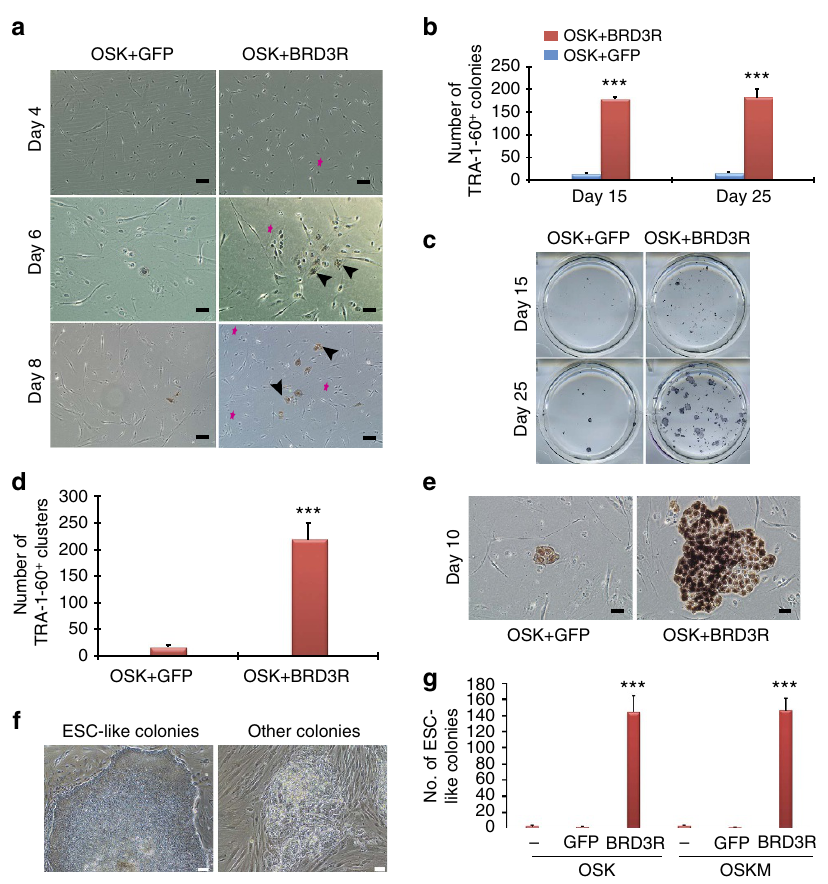
Figure 2 | BRD3R speeds up reprogramming kinetics and enhances the quality of reprogramming. ( a ) Representative images showing early appearance of TRA-1-60 þ clusters in BRD3R reprogramming. Arrowhead, TRA-1-60 þ clusters; magenta star, compact rounded cells resembling mitotic cells and ESC morphology. ( b ) Significant higher TRA-1-60 þ colonies in middle stage of reprogramming (day 15) ( n ¼ 3; mean ± s.d.; *** P o 0.001; t -test). ( c ) Representative images of reprogramming dishes stained for TRA-1-60 on day 15 and day 25 from experiments in b . Note the larger colonies in BRD3R reprogramming. ( d ) Significantly more TRA-1-60 þ clusters are found at early stage of reprogramming (day 10) ( n ¼ 3; mean ± s.d.; *** P o 0.001; t -test). ( e ) Representative images of the TRA-1-60 þ clusters from experiments in d to show the larger size of clusters in BRD3R dishes. ( f ) Representative images of ESC-like colonies (left) and low-quality colonies (right) on which the quantification in g was based. ESC-like colony has clear border with smooth colony surface and contains homogeneous cells, whereas the low-quality colonies have ragged colony border and surface, and contain heterogeneous cells. ( g ) BRD3R reprogramming generated more ESC-like colonies in the primary reprogramming dishes ( n ¼ 3; mean ± s.d.; t test). ( a , e ) Scale bar, 50 m m; ( f ) Scale bar, 100 m